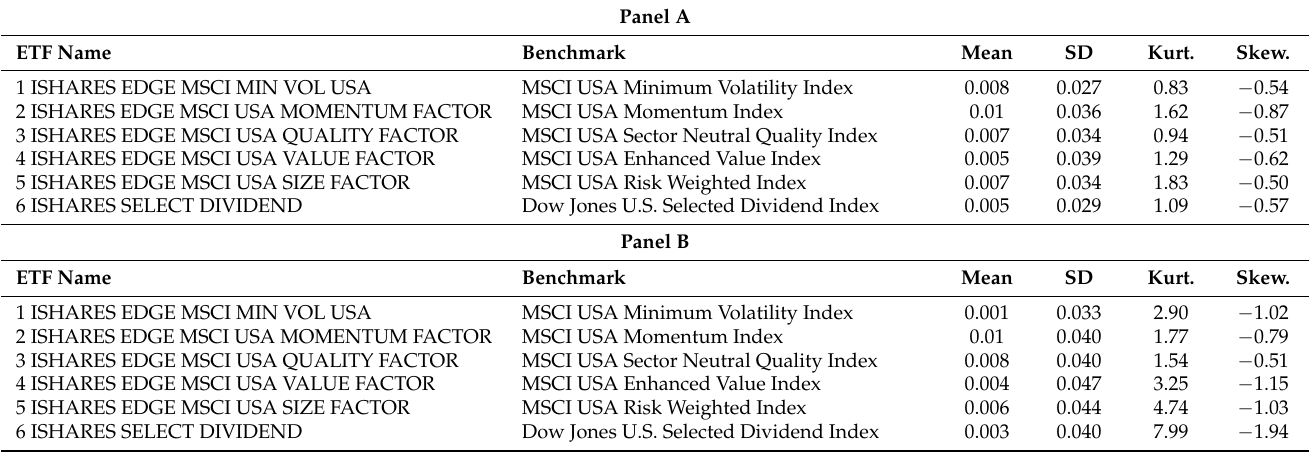
Table 1. Exchange traded funds (ETF) return summary statistics. Summary statistics for exchange traded funds: mean, standard deviation, excess of kurtosis, and skewness. Panel A includes data from January 2014 to May 2019, Panel B